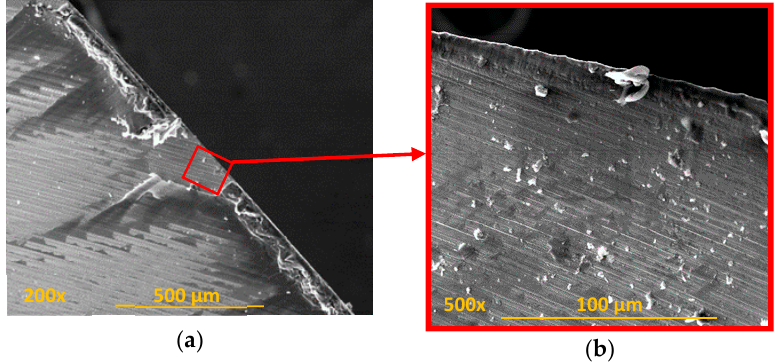
Figure 11. ( a ) Primary adhesion mechanism; ( b ) geometric irregularities observed in the cutting edges.